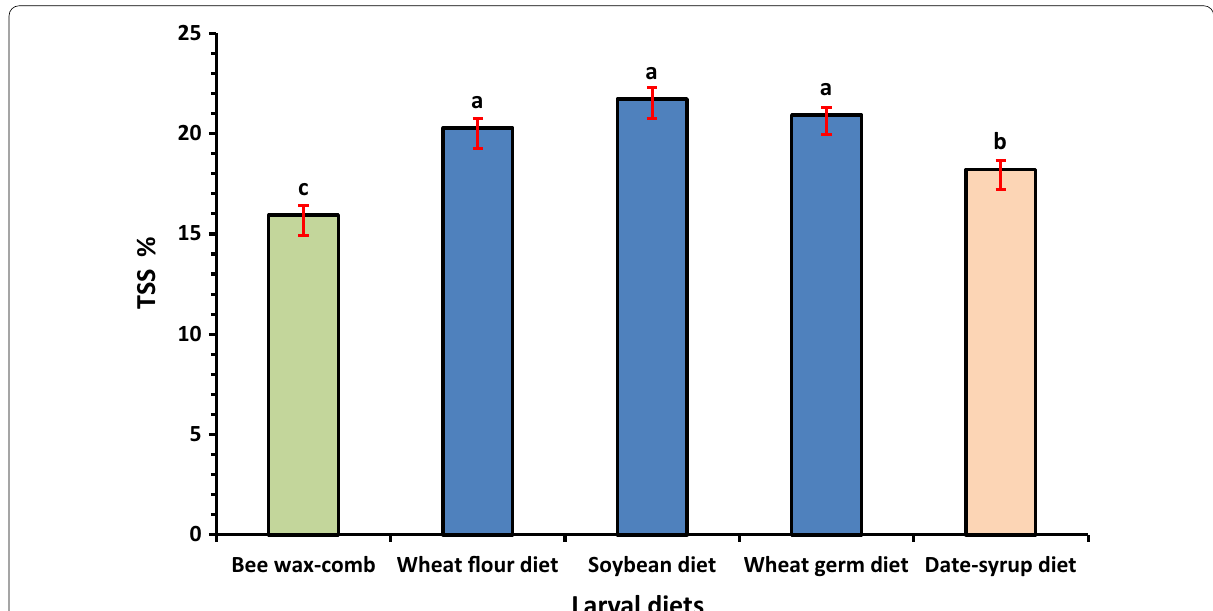
Fig. 2 Effect of different larval nutrition’s of Galleria mellonella on the total soluble solids % (TSS). Means denoted different letters are significantly different (ANOVA, F 4,45 24.138; p < =